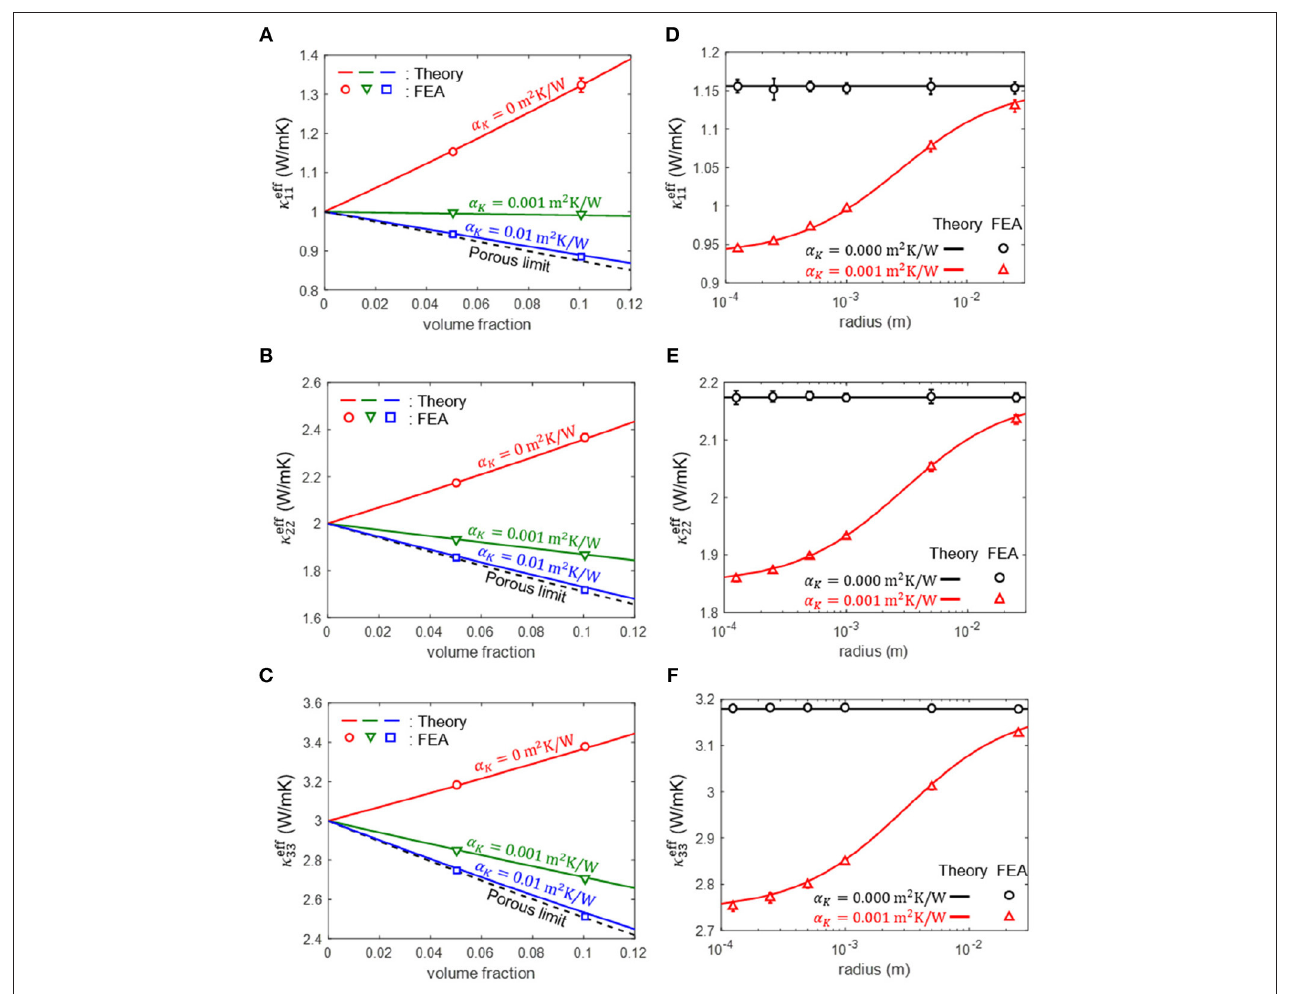
FIGURE 9 | Effective thermal conductivity values [ (A) κ eff 11 , (B) κ eff 22 , and (C) κ eff 33 ] of a particle-reinforced composite with different interfacial thermal resistances. The material properties of the matrix and particle are κ 0